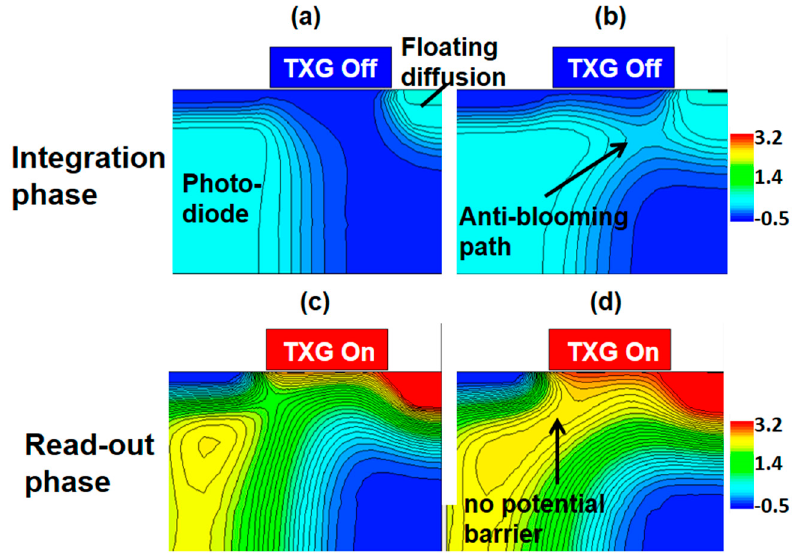
Figure 10. 3D TCAD simulations of the transfer device structure showing electrostatic potential contours. ( a ) The control pixel during the integration phase; ( b ) the pixel in this experiment during the integration phase; ( c ) the control pixel during the read out phase; ( d ) the pixel in this experiment during the read out phase.